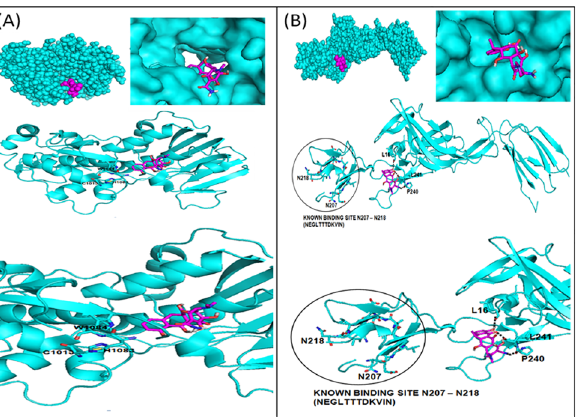
Fig 2. Docking studies of DOXY to CHIKV cysteine protease and E2 glycoprotein. The input files for AutoDock Vina were prepared using AutoDock Tools 1.5.6 where a grid box of 30x30x30 Å 3 was used by the default settings of 10 docked conformations for each run with the Iterated Local Search global optimizer algorithm. (A) DOXY and viral protease binding is due to non-polar and van der Waal interactions. The predicted binding of DOXY to protease was not at the binding site indicating to possible non-competitive inhibition of DOXY against CHIKV protease. (B) Binding of DOXY to viral E2 glycoprotein involved the amino acids L16, P240 and L241 in addition to known E2 binding site to cell receptors